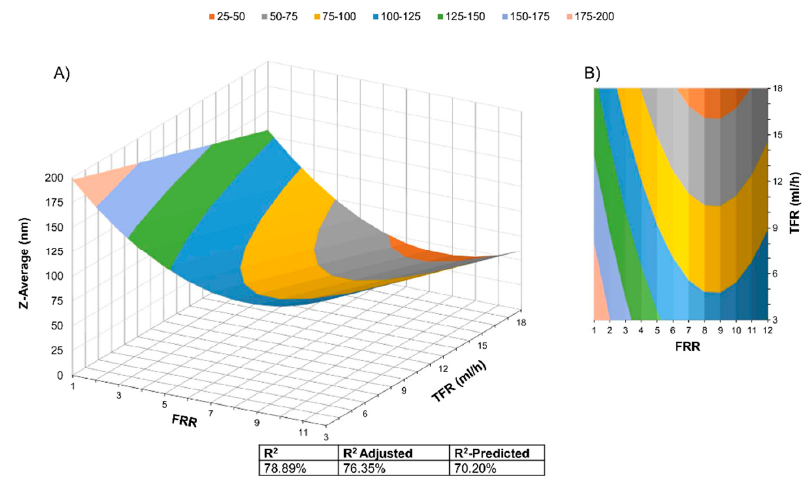
Figure 3. Surface Response Model derived from the Central Composite Circumscribed Rotatable Design Data. The model level of significance is p < 0.05. ( A ) 3 ‐ dimensional, ( B ) Contours representation.